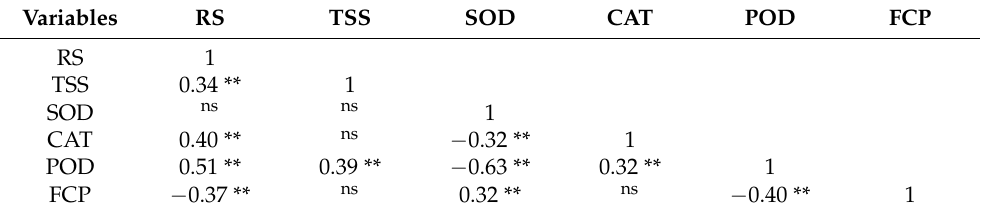
Table 5. Simple correlation matrix between reducing sugar content (RS); total soluble sugar content (TSS); the activity of superoxide dismutase (SOD), catalase (CAT), and peroxidase (POD); and commercial fresh matter (FCP) of iceberg lettuce cultivars under different shade